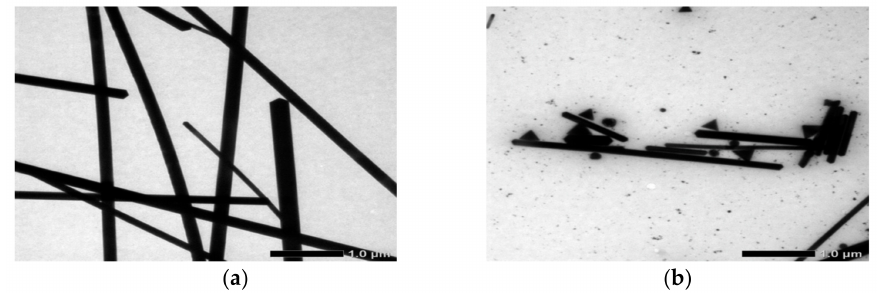
Figure 3. TEM images of AgNWs at quenching medium temperature 27 ◦ C. ( a ) non-vibrated and ( b ) vibrated.